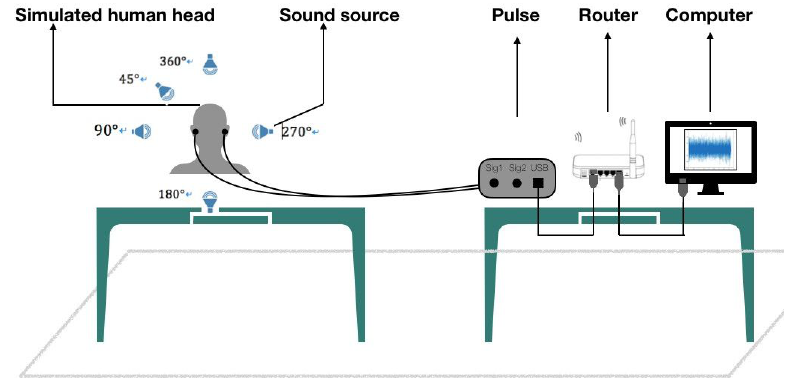
Figure 7: Schematic diagram of experimental equipment